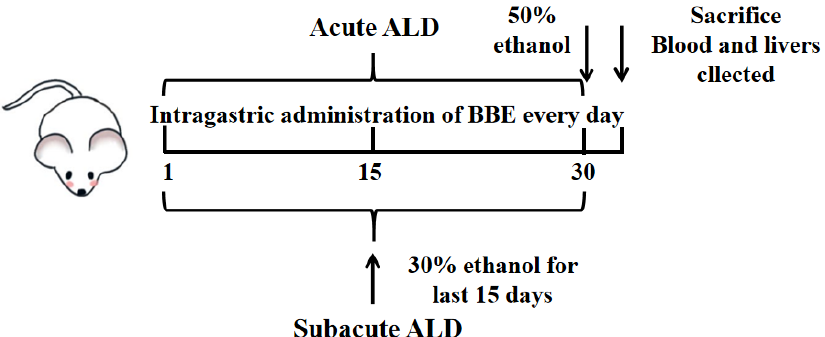
Figure 1. Experimental protocol for the establishment of ALD and the treatment